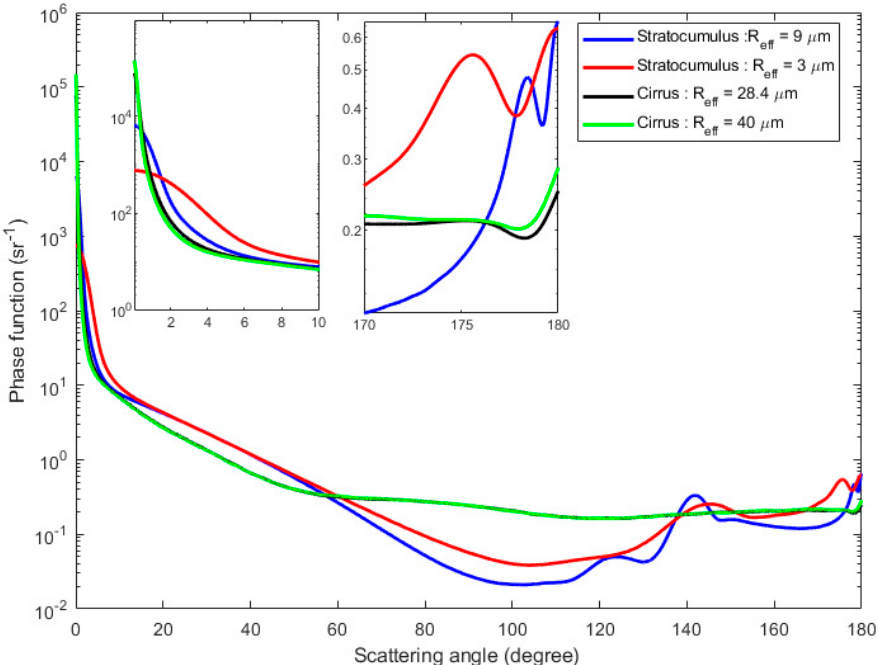
Figure 2. Normalized phase function: stratocumulus ( R ef f = 3 µ m—red line; R ef f = 9 µ m—blue line) and cirrus ( R ef f = 28.4 µ m—black line; R ef f = 40 µ m—green line).